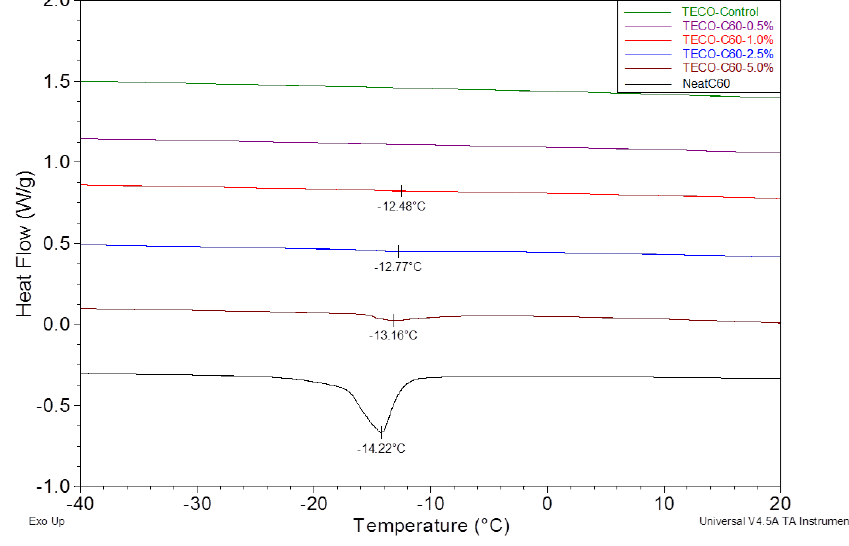
Figure 3. Comparison of DSC thermograms for Tecoflex films containing C